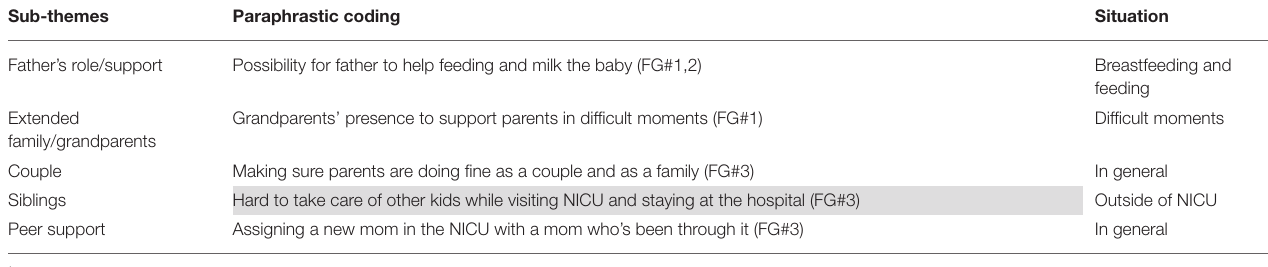
TABLE 5 | Family, couple and peer support.